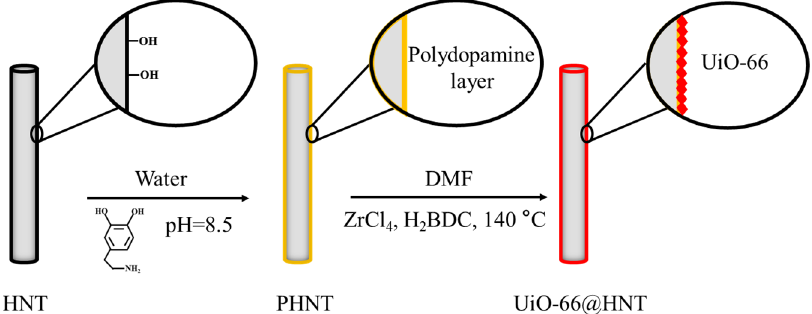
Figure 1. The preparation procedure of UiO-66@HNT.